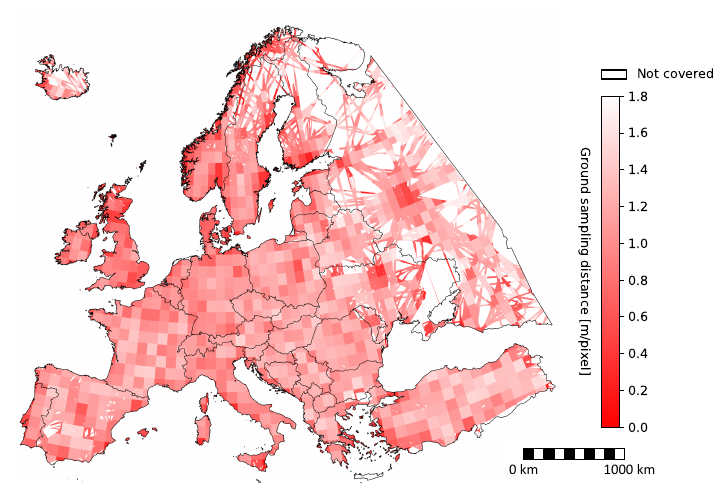
Figure 17. Spatial resolution expressed as average GSD for all flights with Imperx T9040.